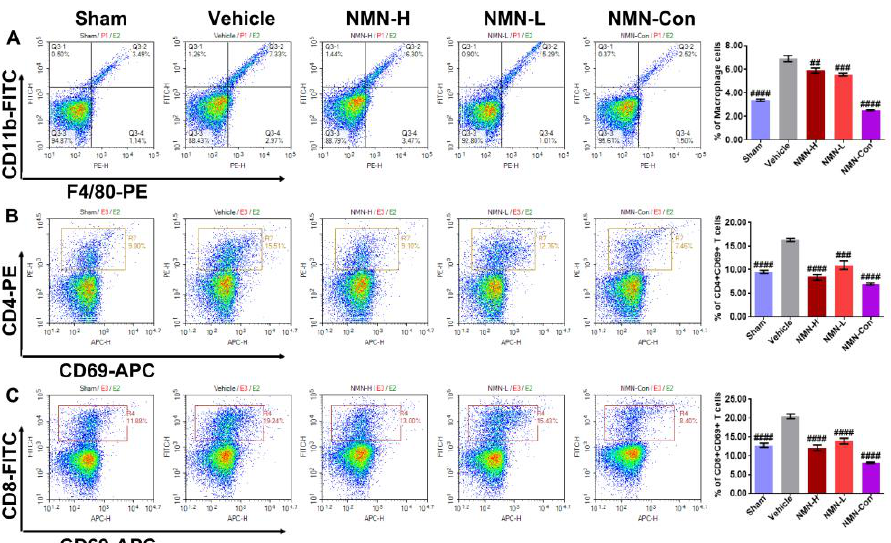
Figure 4. NMN intervention for 7 days decreases the proportion of macrophages, CD4 + CD69 + T cells, and CD8 + CD69 + T cells in silica-induced lung injury. ( A ) Proportions of macrophages in lung tissue; ( B ) proportions of CD4 + CD69 + T cells in lung tissue; ( C ) proportions of CD8 + CD69 + T cells in lung tissue. ## indicates p < 0.01, ### p < 0.001, #### p < 0.0001 vs. Vehicle). Sham: saline + saline; Vehicle: silica + saline; NMN-H: silica + NMN (1000 mg/kg); NMN-L: silica + NMN (500 mg/kg); NMN-Con: saline + NMN (1000 mg/kg).